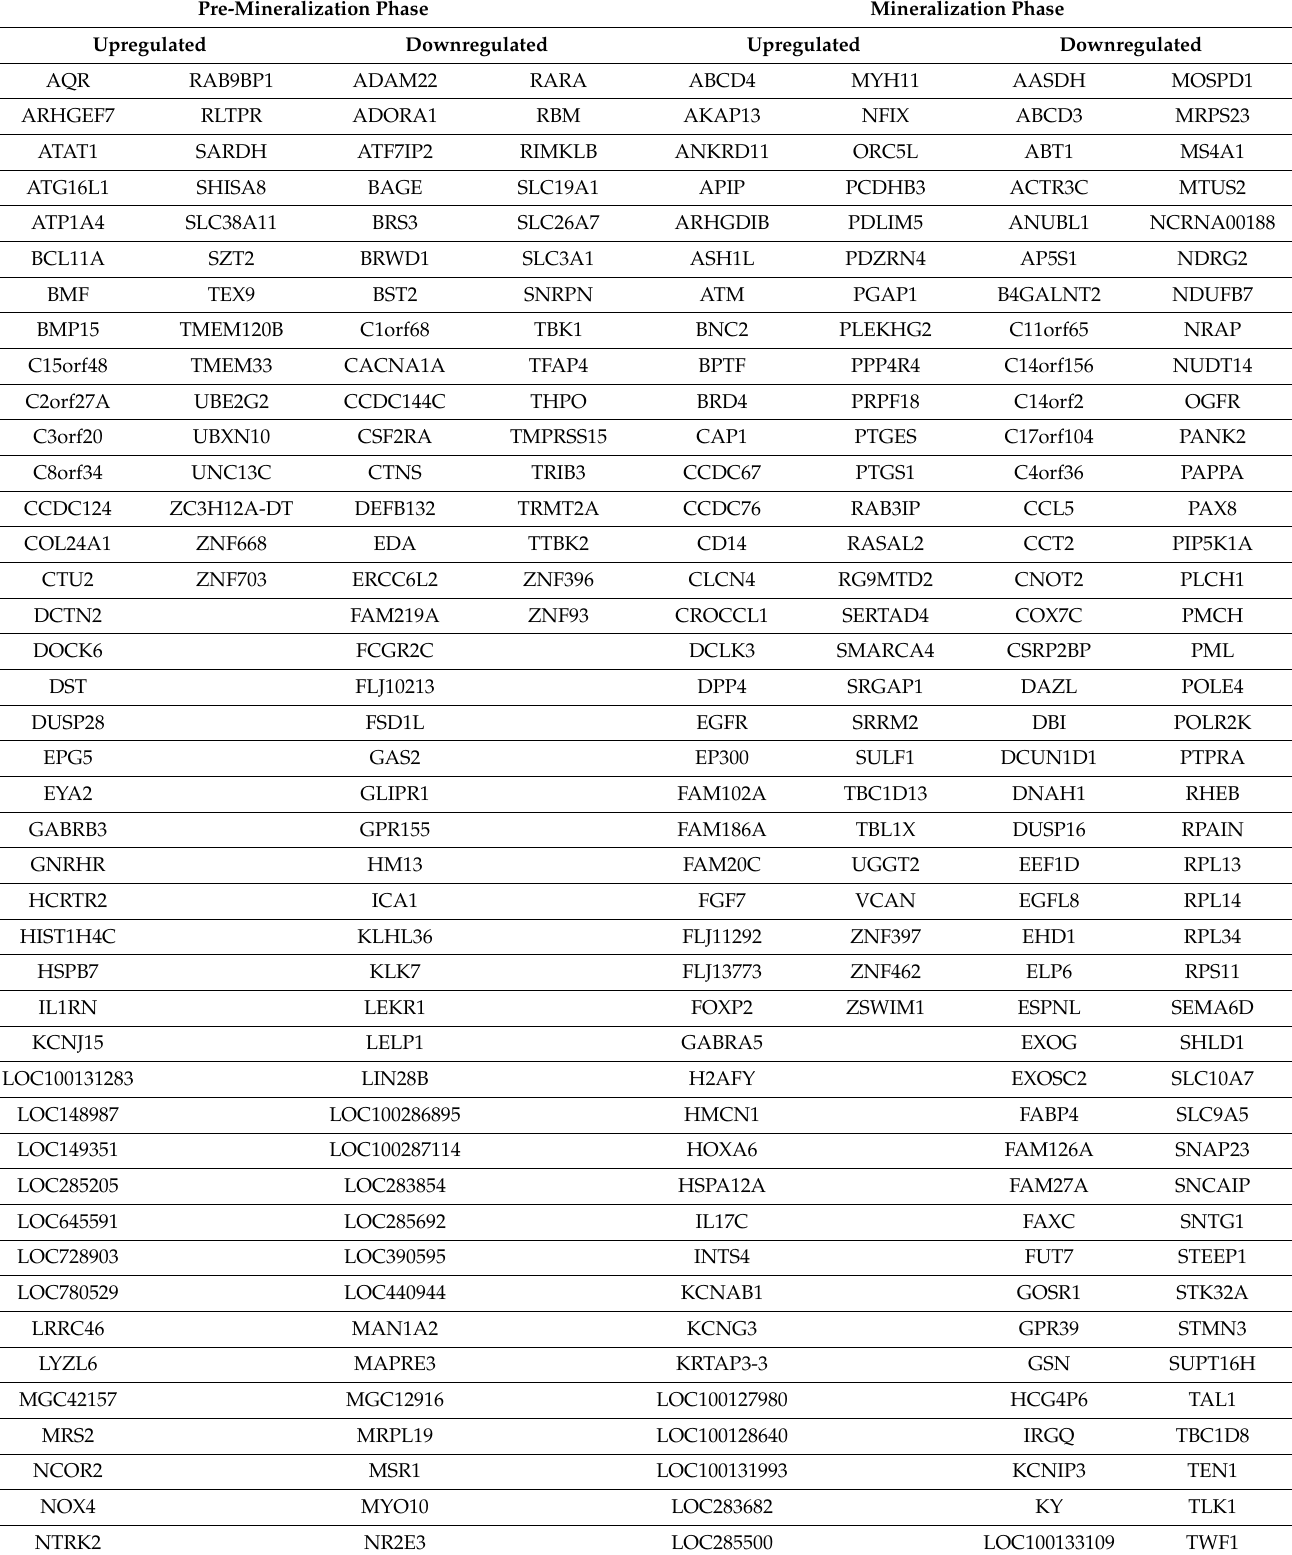
Table 4. Overview of transcript gene names that are uniquely 2-fold up- or downregulated in either the pre-mineralization or mineralization phase of human osteoblasts